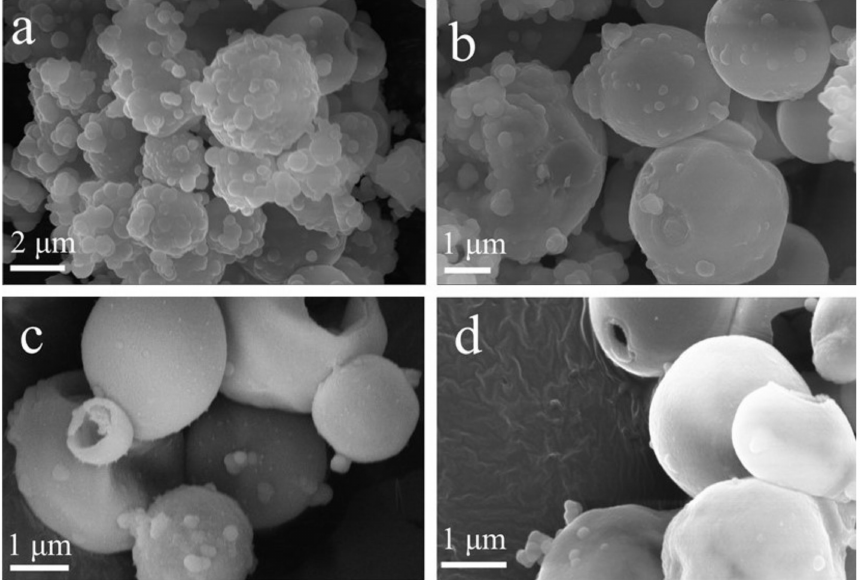
Figure 3. SEM images of SiO 2 synthesized at different ratios of water to ethanol: ( a ) 1/1; ( b ) 1/1.5; ( c ) 1/2; ( d )